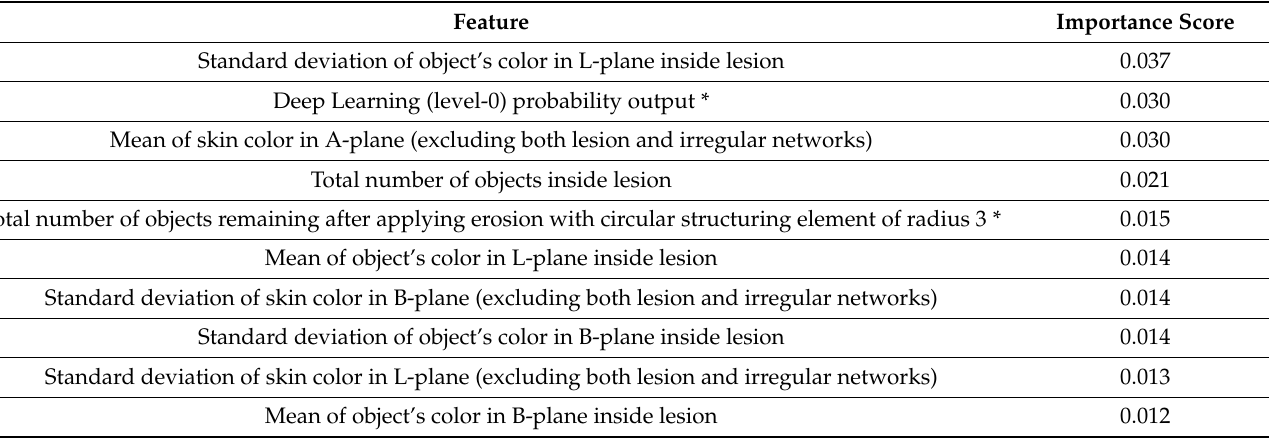
Table 7. Table shows the 10 most important features based on the mean accuracy decrease after feature permutation. The scores are the averaged mean importance scores for all conventional classifiers with Cascade Generalization. Note that objects are non-overlapping distinct contours (blobs) in the irregular network binary mask generated by the segmentation